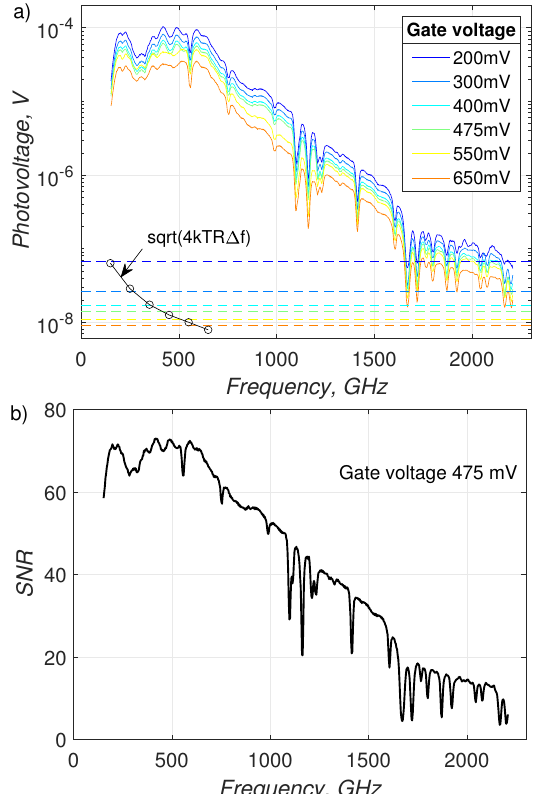
Figure 4. ( a ) Comparison of homodyne system signals for different gate biases. The corresponding noise levels for each bias are marked with dashed lines. The black hollow dots are the calculated noise level of the detector (thermal noise). ( b ) The frequency-dependent signal-to-noise ratio of the THz detector at the gate voltage of 475